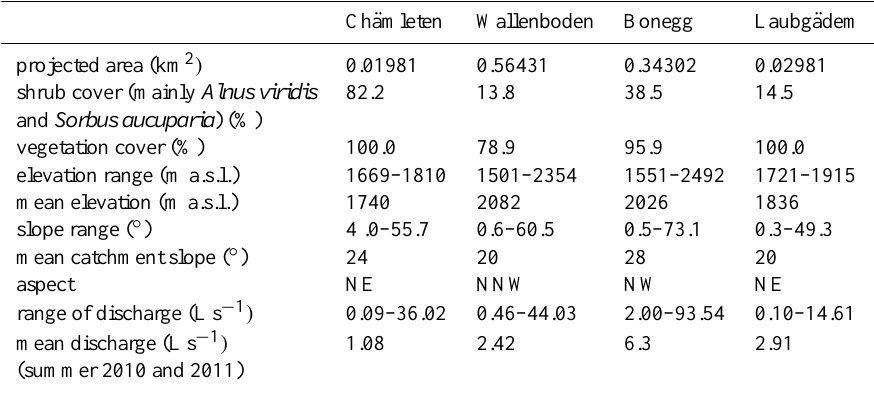
Table 1. Characteristics of micro catchments (vegetation data from van den Bergh et al., 2011, and Fercher, 2013 (modified); discharge data from Lagger, 2012, and Schmidt,